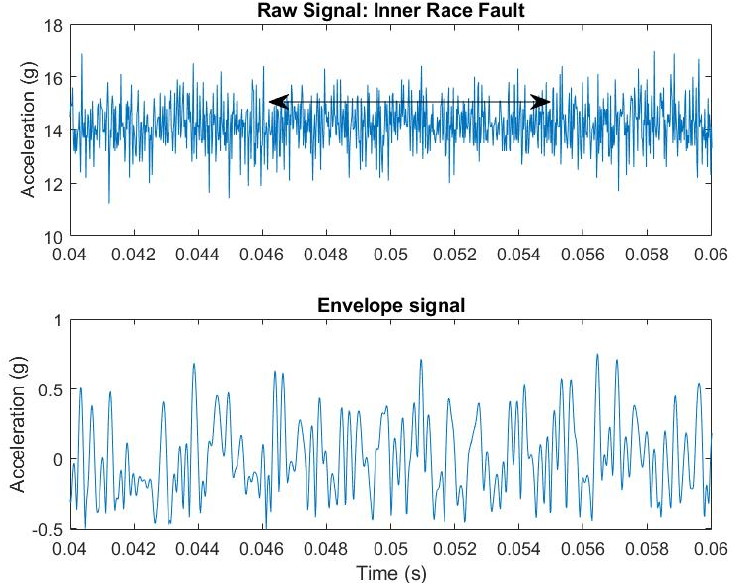
Figure 13. Power spectrum of raw signal.